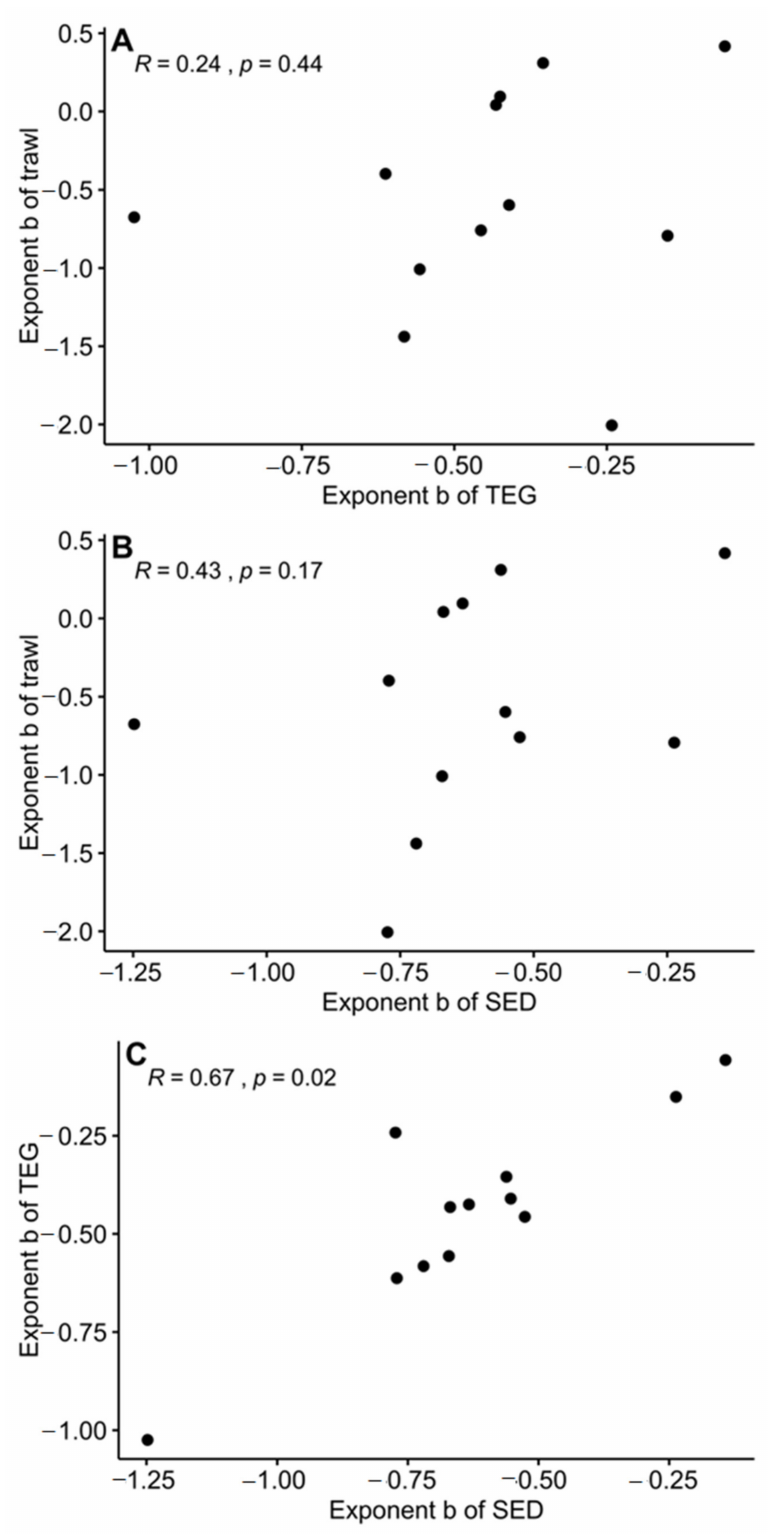
Figure 5. Scatter plot and Spearman rank correlation of exponents b between trawling and hydroa- coustic tracked-echo groups (TEGs) ( A ), trawling and hydroacoustic single-echo detections (SEDs) ( B ), and between hydroacoustic SEDs and TEGs ( C